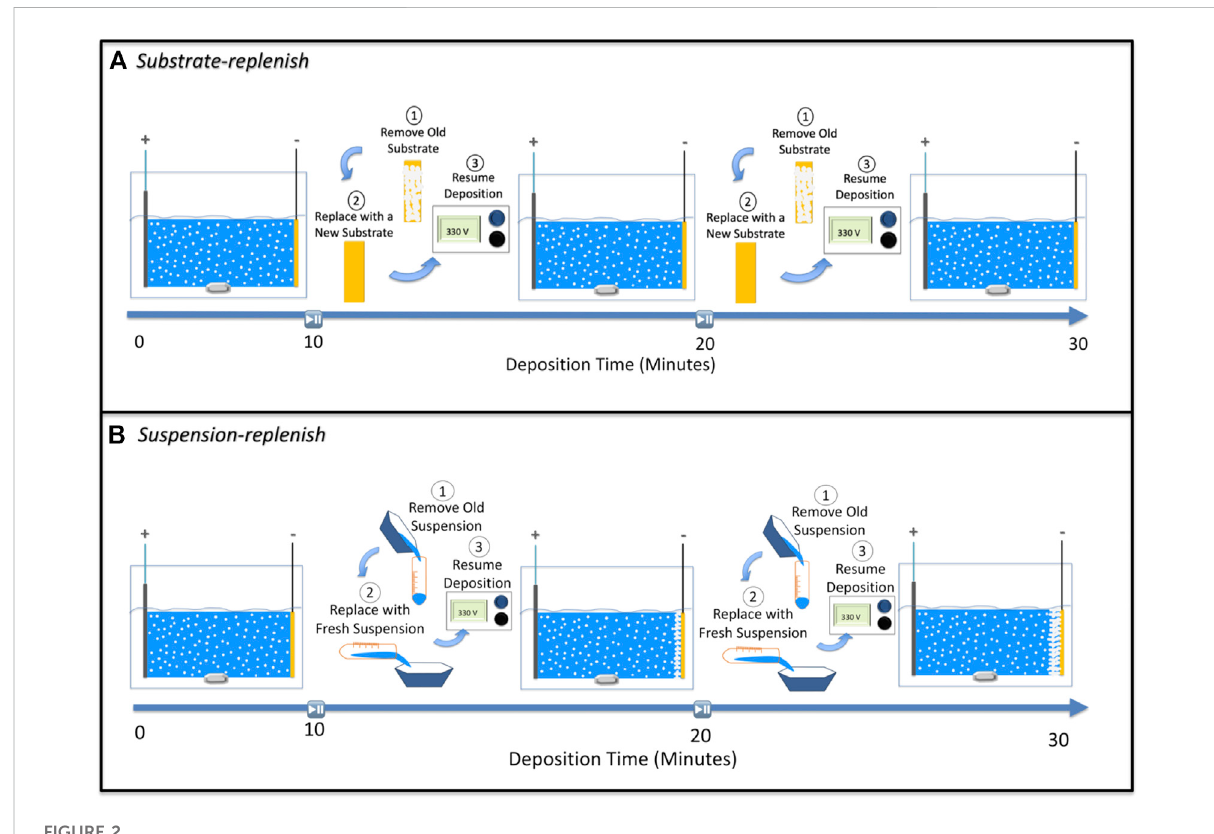
FIGURE 2 Schematic showing steps involved in (A) substrate-replenish electrophoretic deposition and (B) suspension-replenish electrophoretic